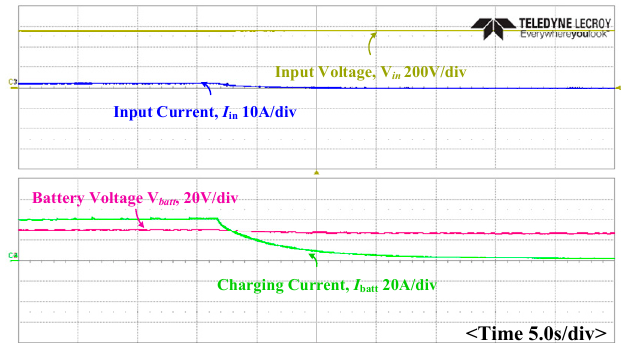
Figure 19. Experimental results of Switching Pattern 3.